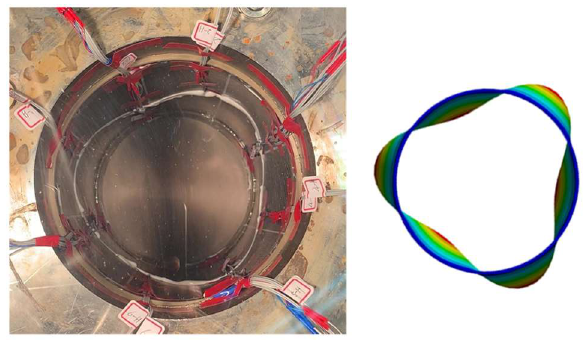
Figure 7. Schematic of the test setup and boundary conditions.